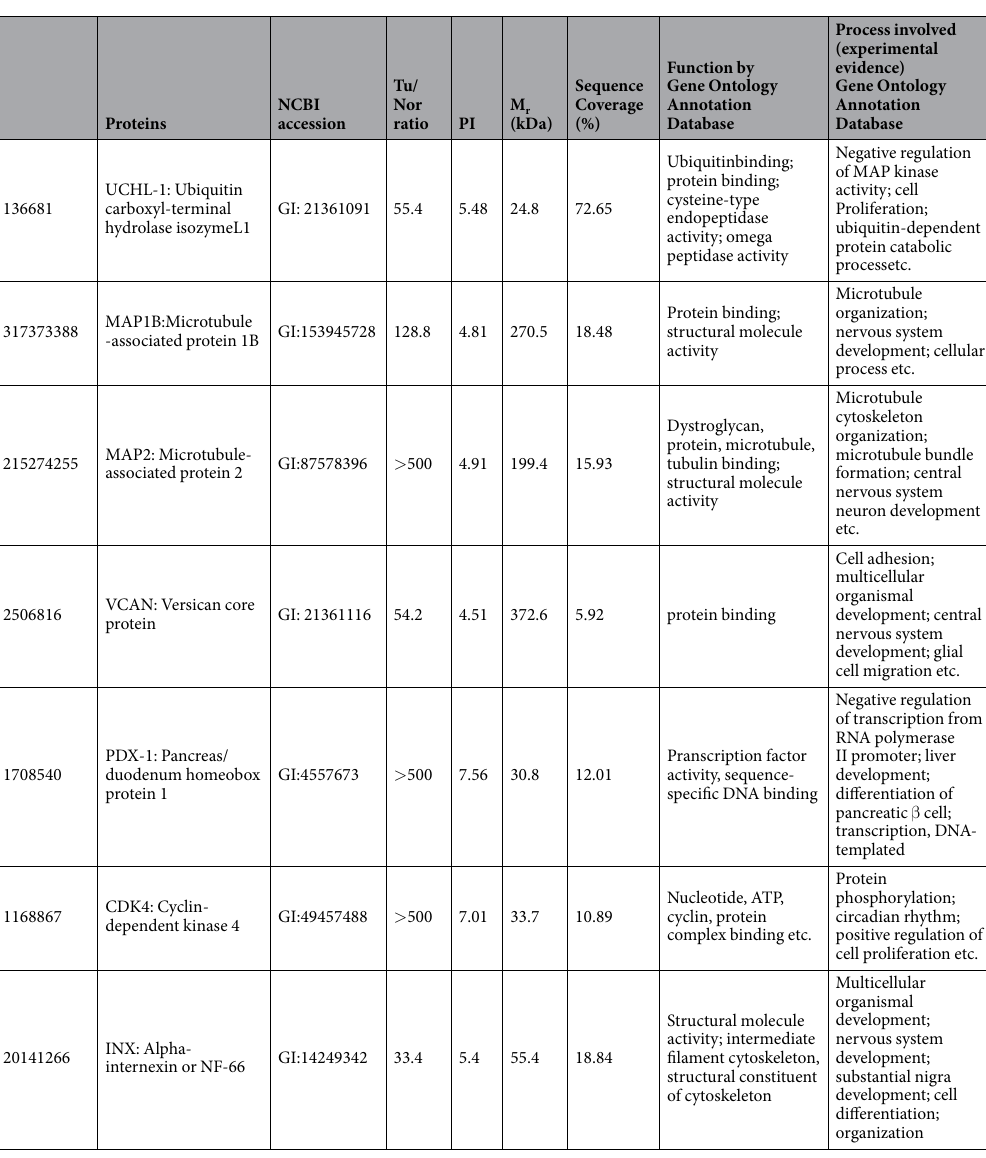
Table 2. Differentially expressed proteins between insulinomas and paired pancreatic